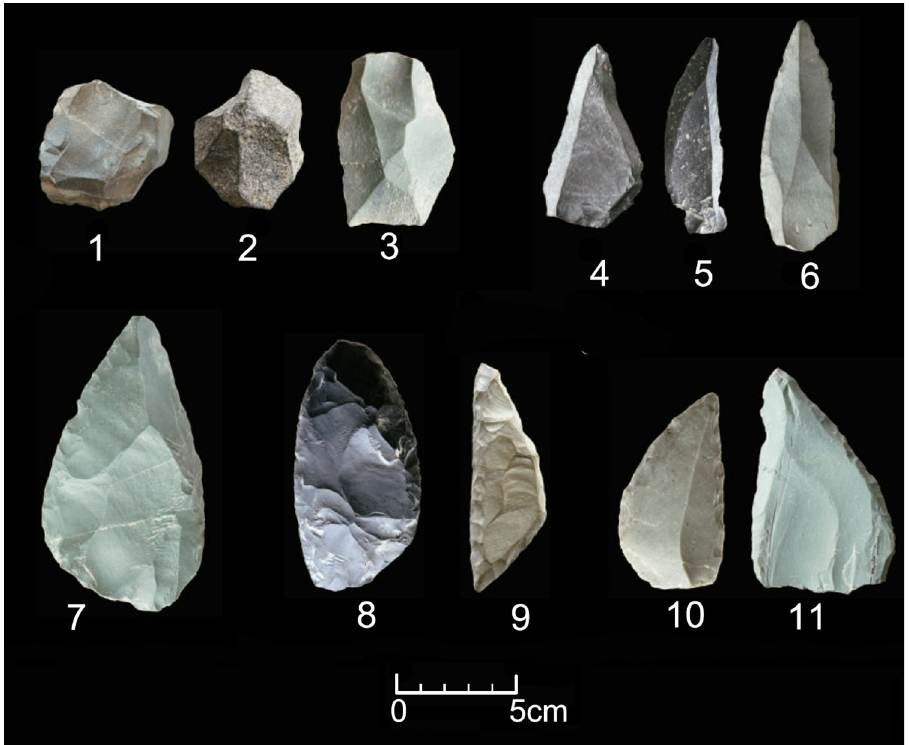
Fig 2. Typical artifacts of the TMP techno-complex found in the Tongtiandong Cave site of Northwest China. (1: Levallois core; 2: Discoid core; 3: Levallois flake; 4,5,6: Levallois points; 7,10,11: Mousterian point; 8,9: Scraper; 1–11: after